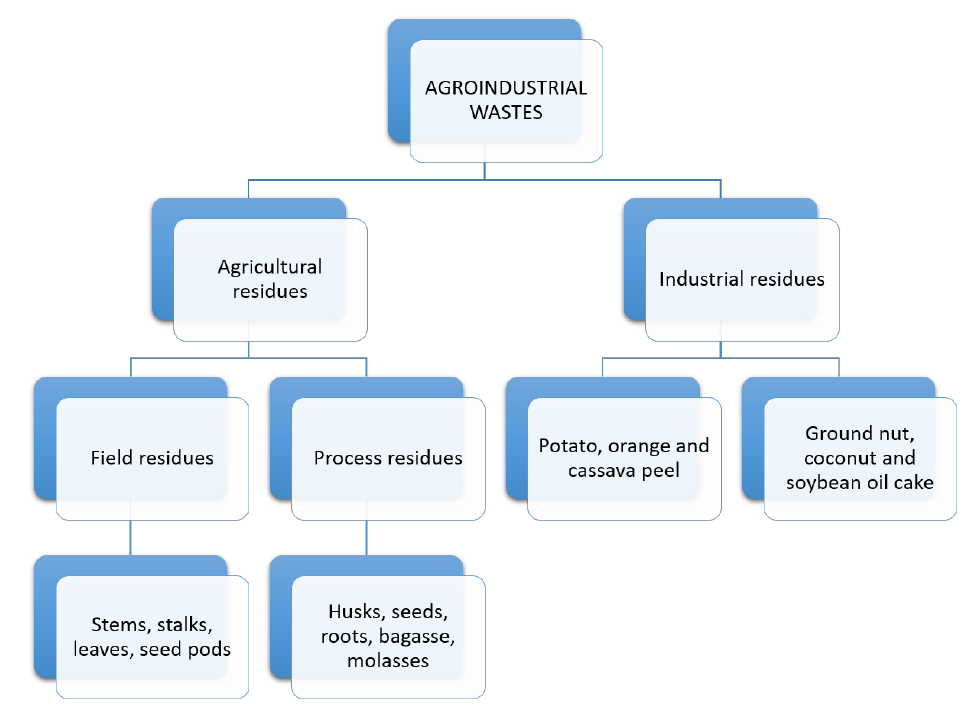
Figure 3. Agro-industrial wastes and their types [7].